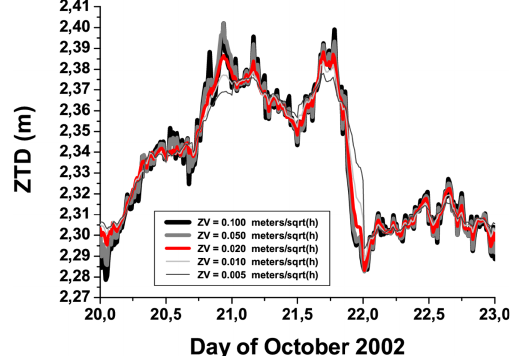
Fig. 6. ZTD at BORD for the time span from 20–22 October 2002 (doy 293–295). Test of the zenith variation (ZV) with values of 0.1, 0.05, 0.02 (reference), 0.01 and 0.005m per sqrt(h) are presented.